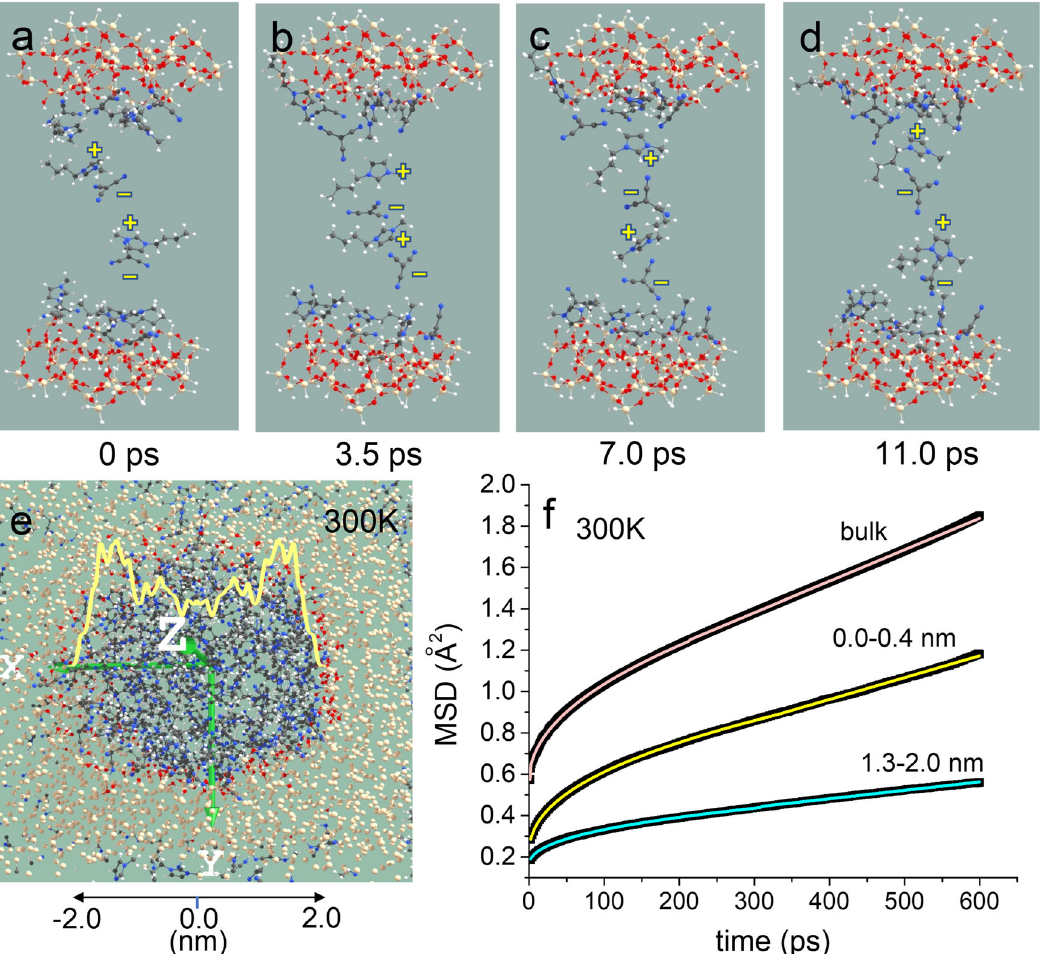
Fig. 5 Dynamic molecular ordering of IL inside MCM-41. a – d Snapshots of ab initio molecular dynamics (AIMD) simulation at 300 K of RTIL molecules con fi ned between two silica “ slabs ” 3.8 nm apart of each other (blue: nitrogen, dark grey: carbon, white: hydrogen, yellow: silicon, red: oxygen). The structure was constraint in the z-axis (vertical to the Figure plane). Most of the RTIL molecules are interacting strongly with the silica surface, whereas the rest are tumbling in the intermediate space, interacting weakly with each other and the adsorbed RTIL molecules. Interaction energies are given in the main article and Supplementary Table 3. Notably, “ free ” RTIL ions form a dynamically ordered state of alternating negatively and positively charged ions (see also Supplementary Movie 1). e Snapshot of a molecular dynamics simulation of RTIL con fi ned in MCM-41 at 300 K. The yellow line is the RTIL radial density distribution. f The MD calculated mean square molecular displacement (MSD) of the RTIL molecules in bulk RTIL and con fi ned in MCM-41 (inner (cid:4) (cid:5) (cid:4) τ 0 : 5 and outer radial shells). At initial times MSD in all cases varies as z 2